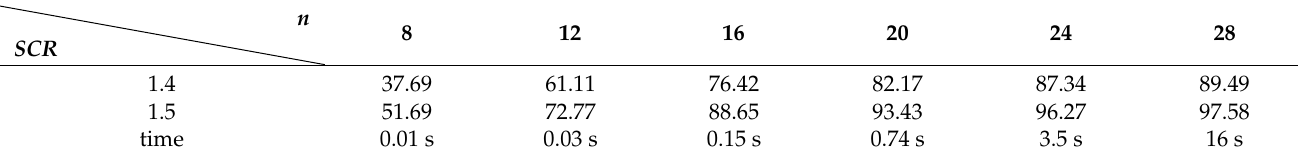
Table 5. P ( dp − mht − tbd ) with F a = 0.001.